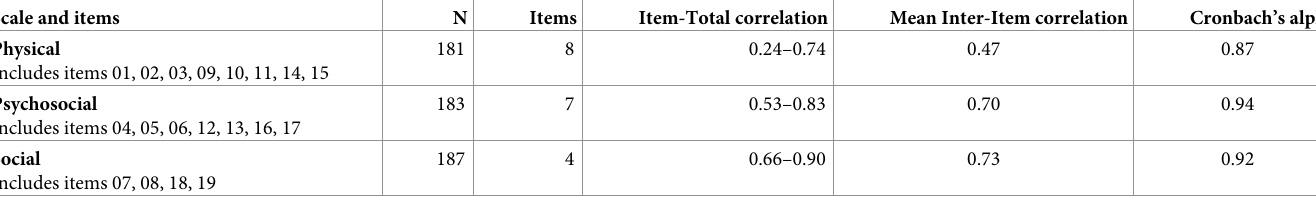
Table 3. Internal